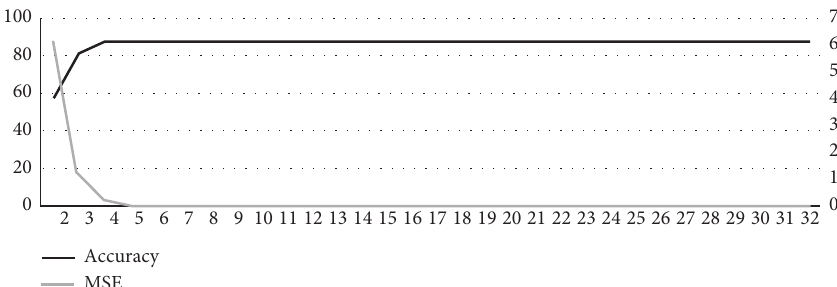
Figure 4: Accuracy and MSE to the change of the number of bits for input layer words.